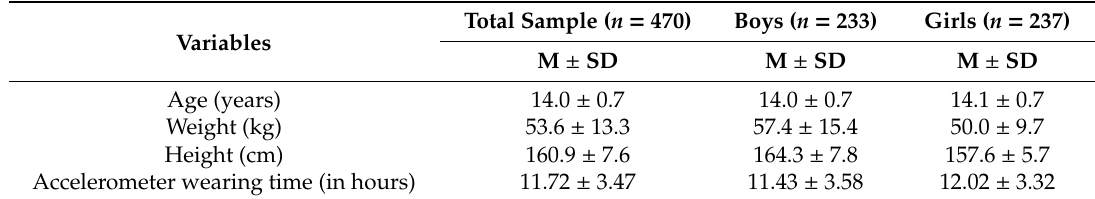
Table 1. Demographic characteristics of study